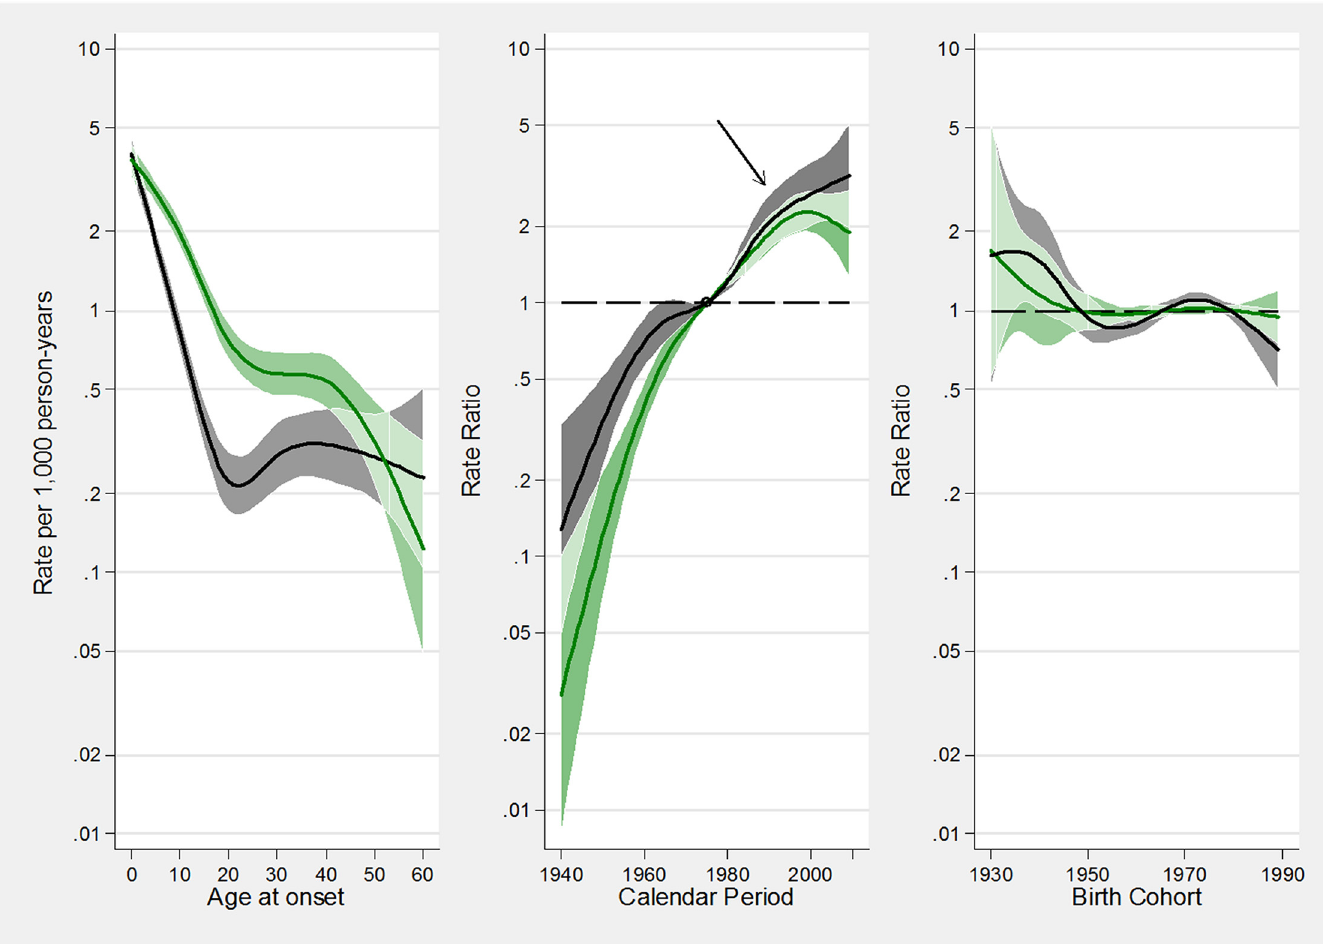
Fig 5. A-C. Estimated effects from the APC models for incidence rates of atopic asthma (green tonalities) and non-atopic asthma (grey tonalities). Fig 5A represents the age-specific incidence rates, referred to the reference period 1975; Fig 5B represents the merged period and drift effects (rate ratios), with linear increasing trend determined by the drift, and deviations from linearity (curvature) determined by the period effect; Fig 5C represents the birth cohort effect. The arrow in B indicates the calendar period when the incidence of asthma has begun to level off. The respective regions surrounding the lines provide the 95% confidence intervals (95%CI). Overlapping 95%CI are highlighted with lighter